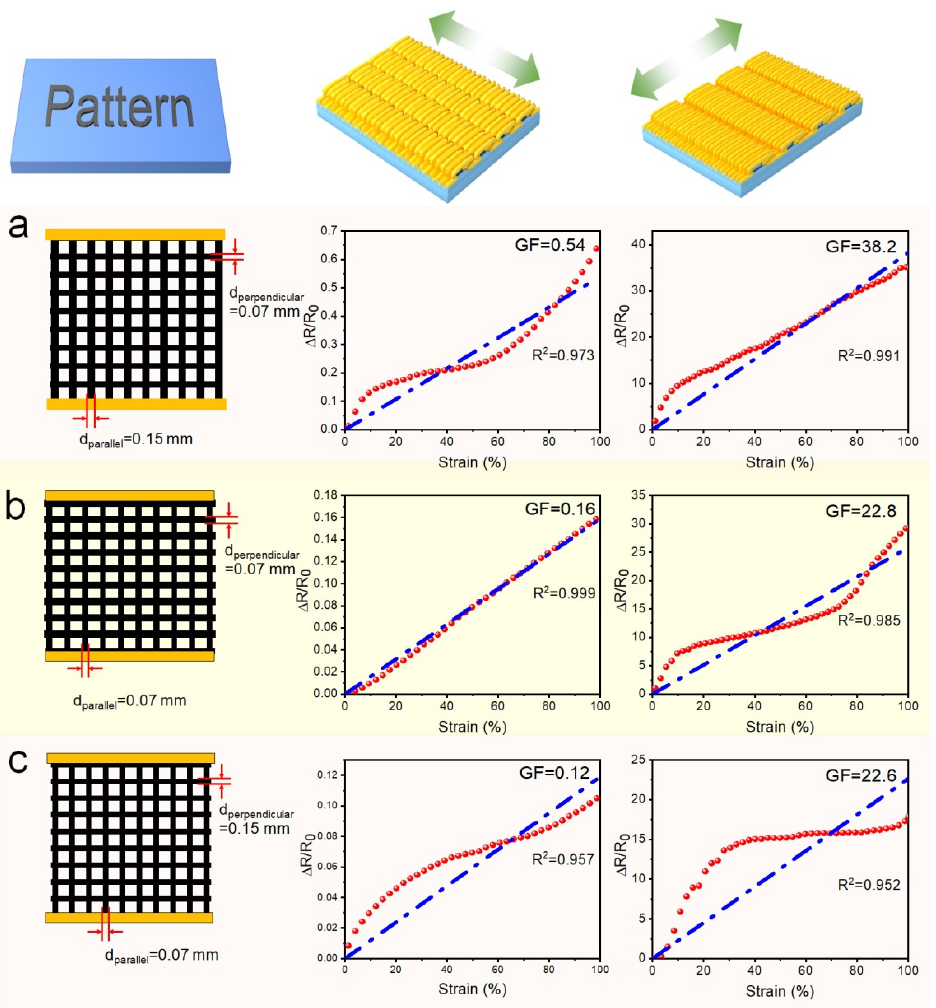
Figure 12. Strain-sensing properties along the directions of first- and second-grade wrinkles in PWG@R-5-60 of different patterns: ( a ) grid lines (bold lines parallel to stretching direction), ( b ) grid lines (normal), and ( c ) grid lines (bold lines perpendicular to stretching direction).